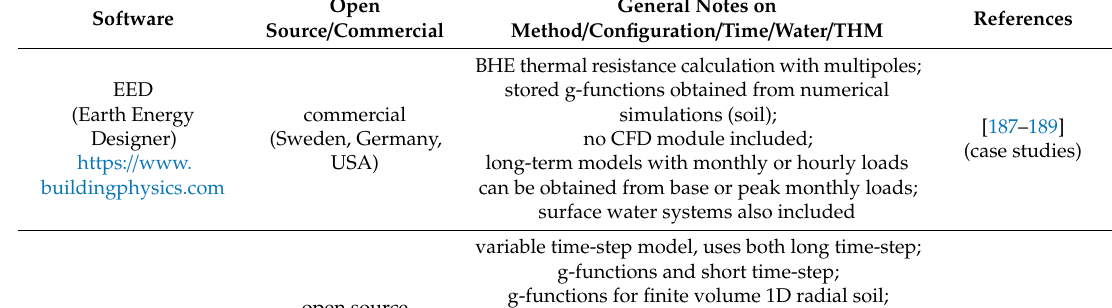
Table 1. Comparison of the most common existing software tools for SGES